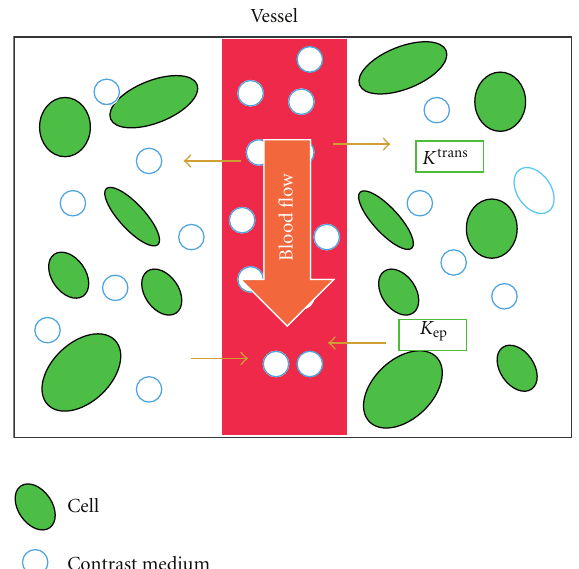
Figure 1: Schematic illustration of the TK model. The model assumes equilibrium of the contrast media between the plasma and the extravascular-extracellular space (EES) and the isodirectional permeability and K trans : influx forward volume transfer constant (into EES from plasma), v e : fractional volume of EES per unit volume of tissue, K ep : the e ffl ux rate constant from the EES to plasma ( K ep = K trans /v e ).